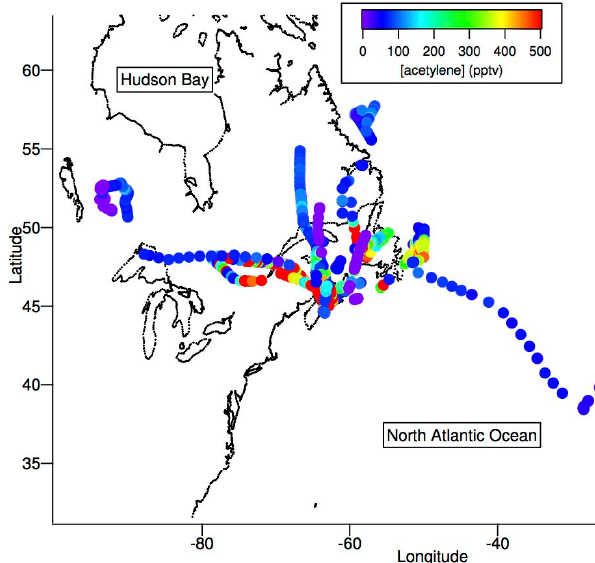
Fig. 1. FAAM146 flight tracks during August 2012, overlaid with sample locations for whole air samples. The points are coloured by acetylene mixing